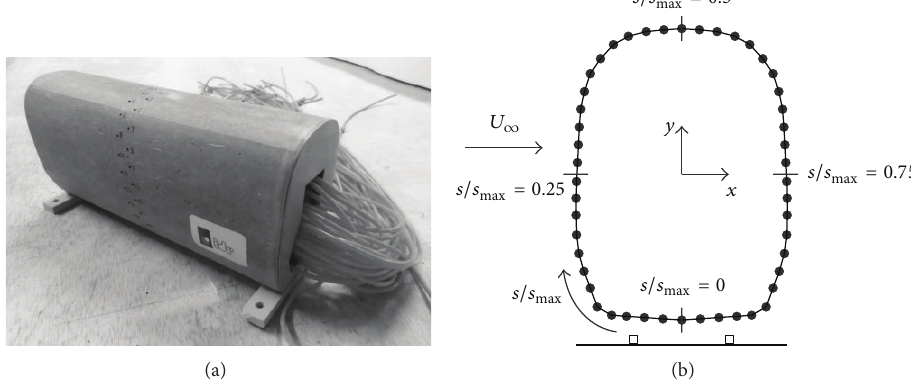
Figure 4: Coach/train model used for the two-dimensional tests during the pressure measurement campaign (a). The nondimensional distance over the train surface at the middle cross-section, 𝑠/𝑠 max , is indicated (b).